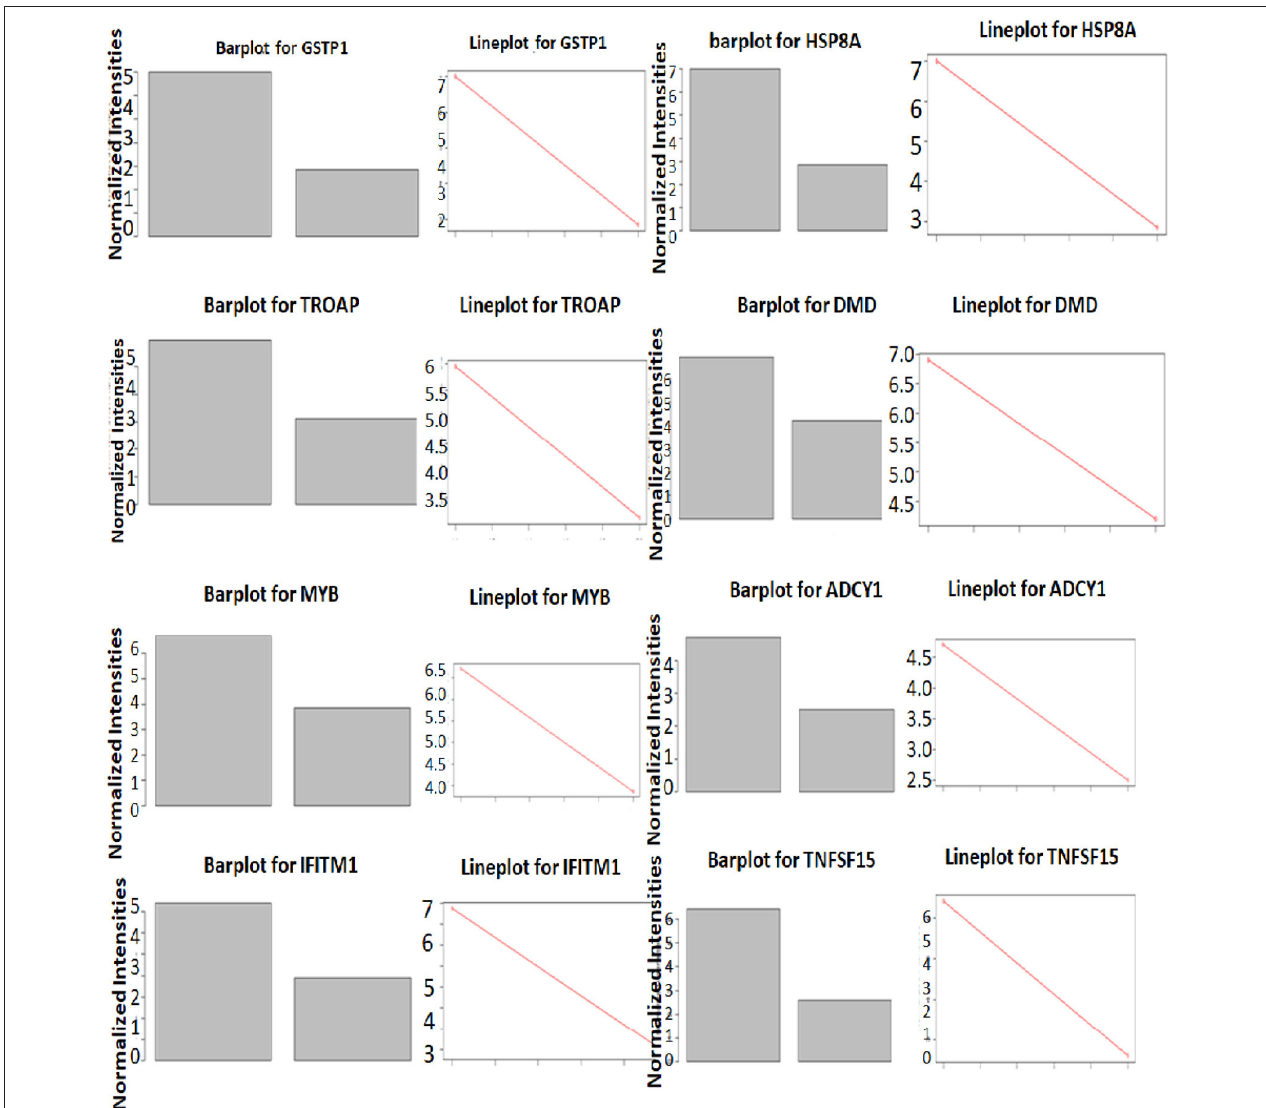
FIGURE 6 | Differential expression of genes in LVNC and control in GSEA enriched pathways. Expression differences of top three genes in LVNC and healthy subjects in three enriched